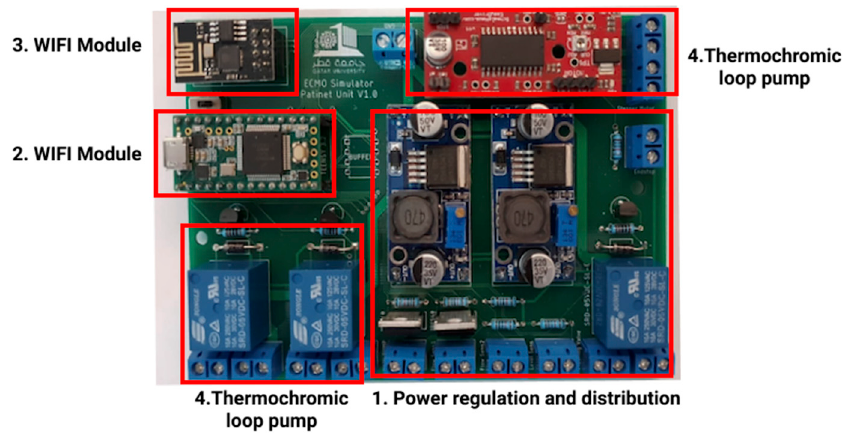
Figure 11. Patient unit main board.